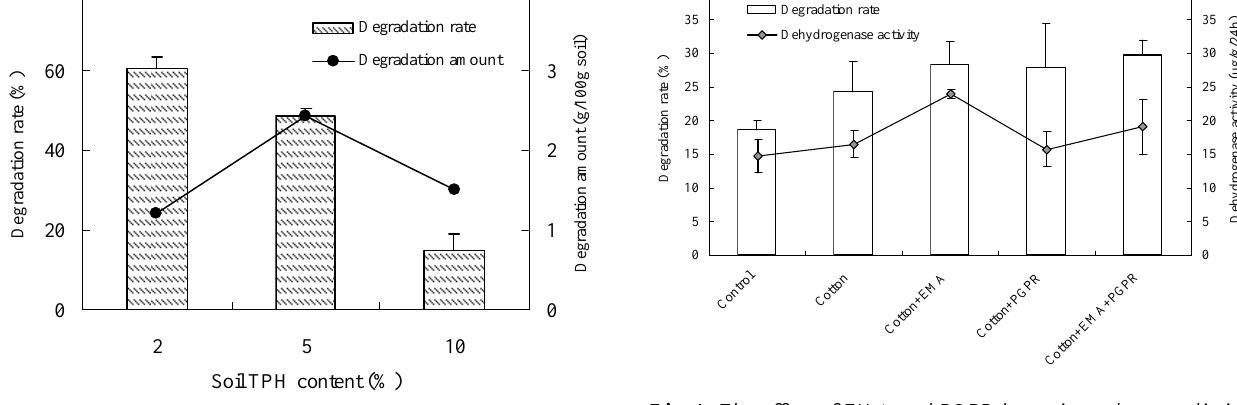
Fig. 3. The effect of soil TPH concentration on the degradation rate.